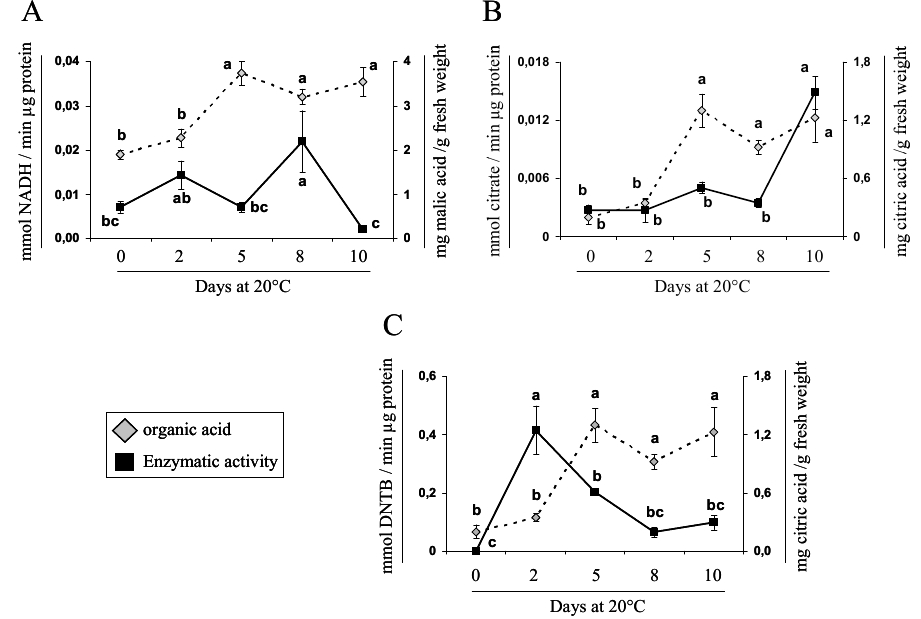
Figure 3. Activity profiles of organic acid-related enzymes during “Concha Lisa” cherimoya ripening. Assays were performed in duplicate using samples of 4 fruits per time point during ripening at 20 °C. The following enzymes were analyzed: ( A ) NAD-dependent malate dehydrogenase, NAD-MDH; ( B ) citrate synthase, CS; and ( C ) aconitate hydratase, ACON . In each panel, enzymatic activity (black rectangles) is related to and compared with the concentration of the respective organic acid (gray rhombus). Different letters between each sample point represent significant differences at p ≤ 0.05 by the LSD test.